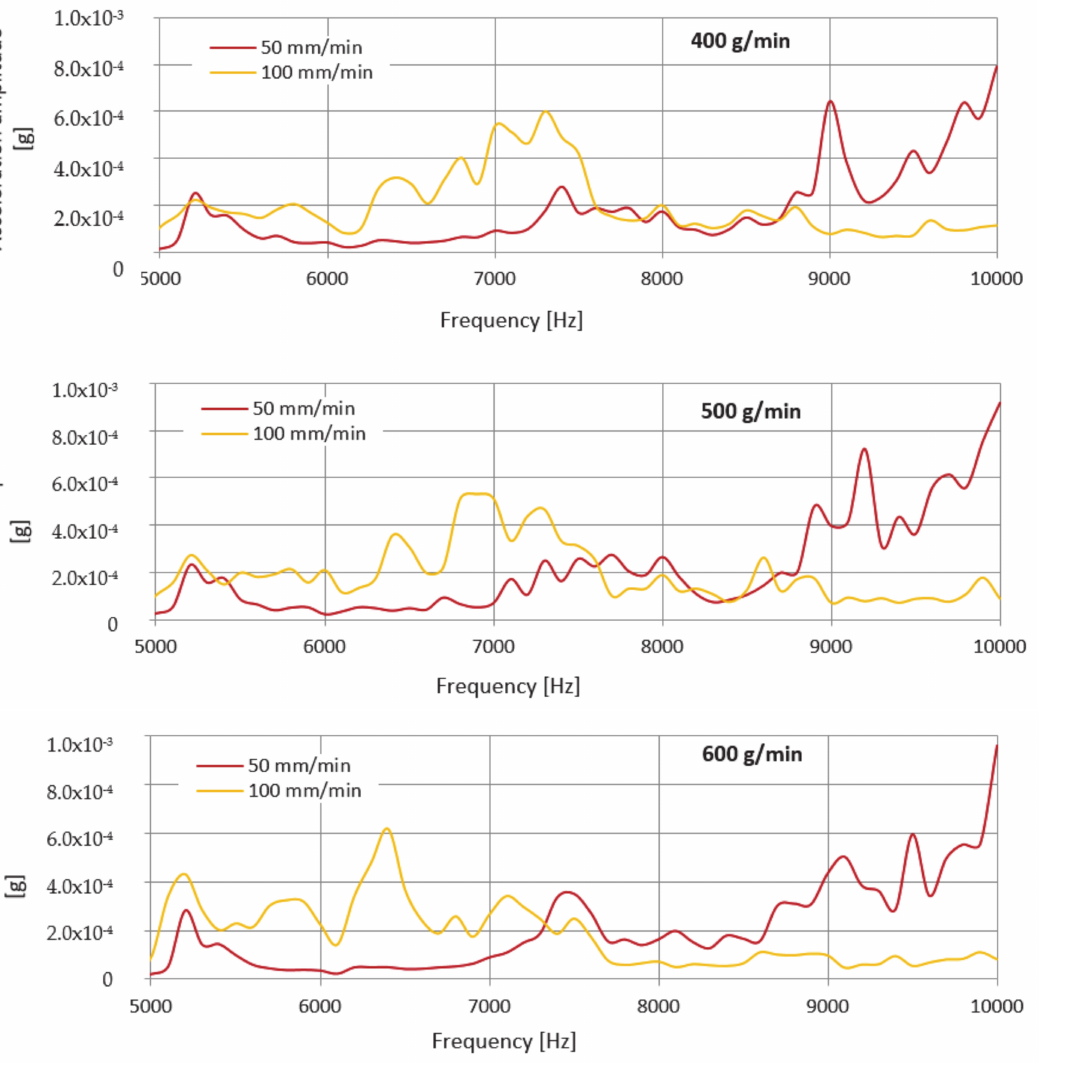
Figure 9. Graphs comparing envelopes of frequency spectra when cutting with an